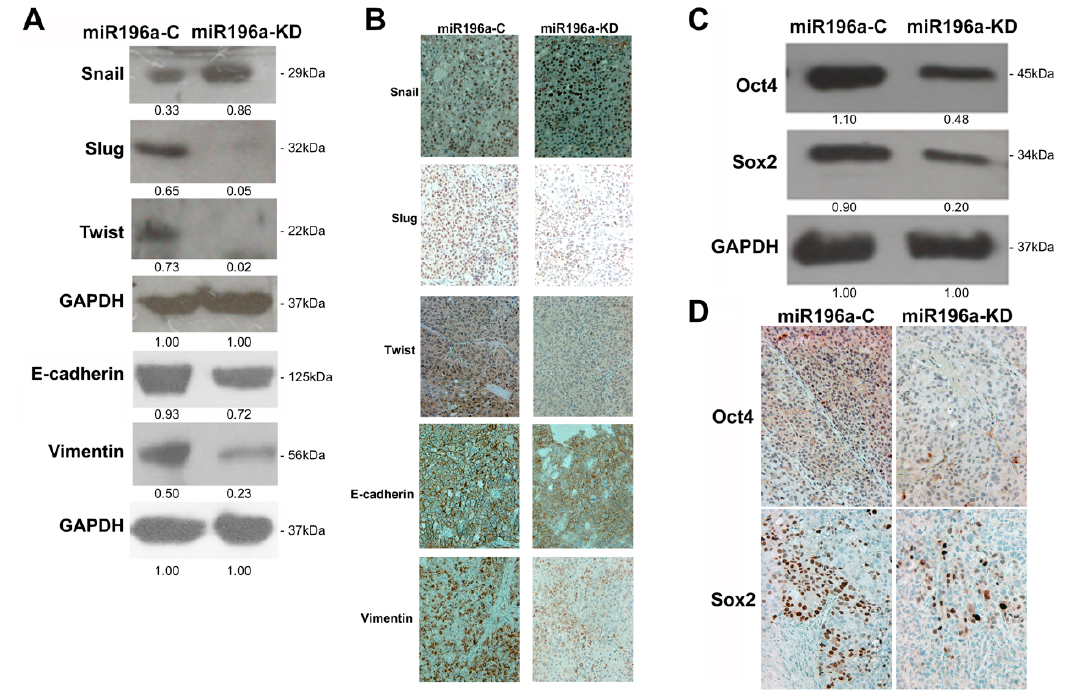
Figure 4. Knockdown of miR-196a modulated epithelial–mesenchymal transition regulators and stemness genes in PLC cells. ( A ) Western blotting indicated that miR-196a downregulation led to a decrease of Slug and Twist. ( B ) Immunohistochemistry revealed that the levels of Slug and Twist were reduced in the xenografts derived from PLC-miR196a-KD compared with those from PLC-miR196a-C (original magnification, ×200). ( C ) Western blotting showed that downregulation of miR-196a reduced the levels of Oct4 and Sox2 in PLC. ( D ) Immunohistochemistry showed that downregulation of miR-196a reduced Oct4 and Sox2 expression in the subcutaneous xenografts derived from miR196a-KD PLC cells compared with those from miR196a-C PLC cells (original magnification, ×200).